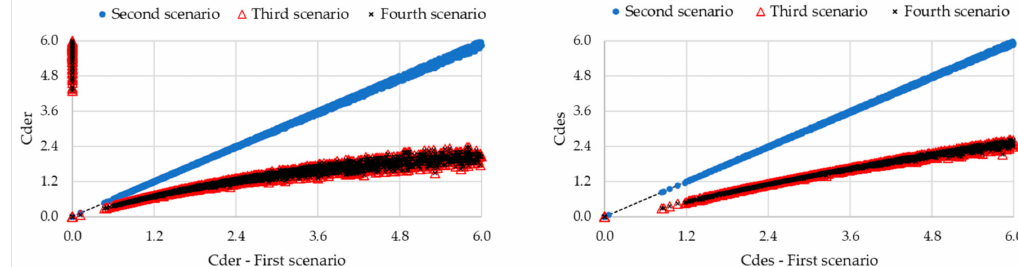
Figure 19. Safety coefficients for the first scenario compared with the second to fourth scenarios—Nørgaard et al.